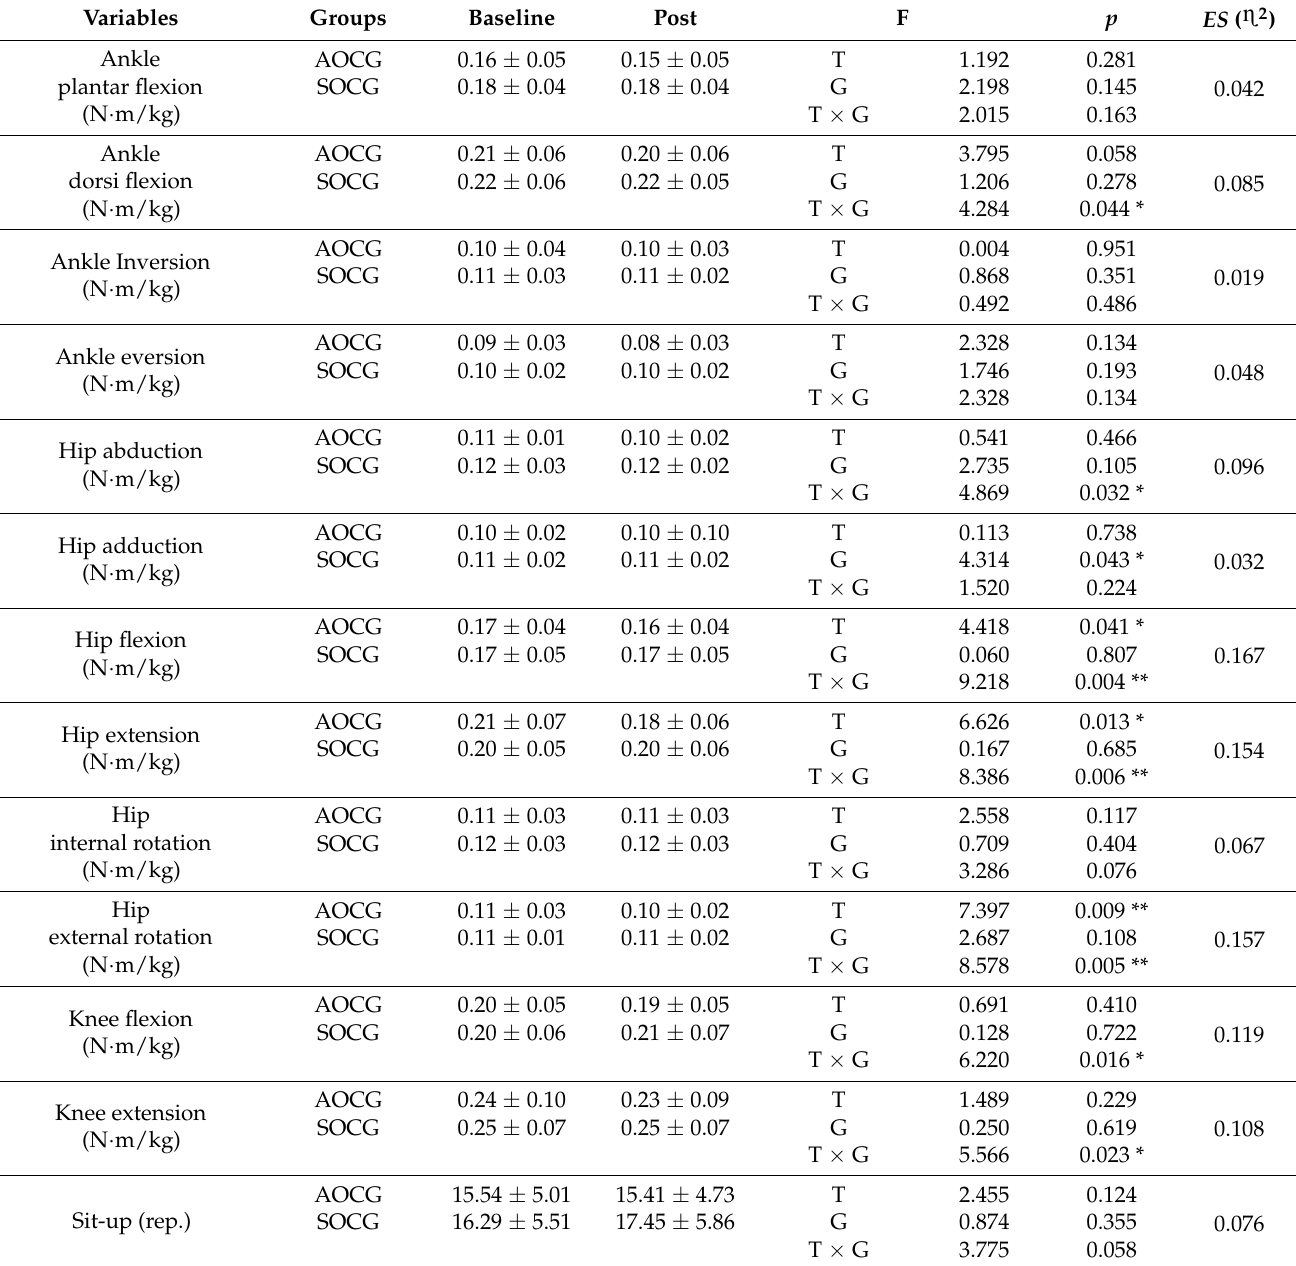
Table 2. Changes in muscle strength and muscle endurance. Table 1. Changes in body